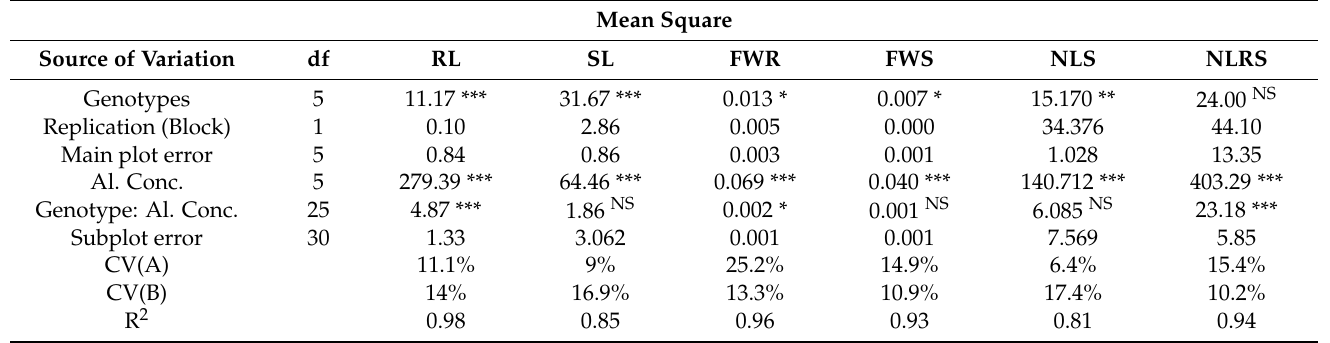
Table 2. Analysis of variance of chickpea genotypes and Al concentrations evaluated in a solution culture under varying levels of Al